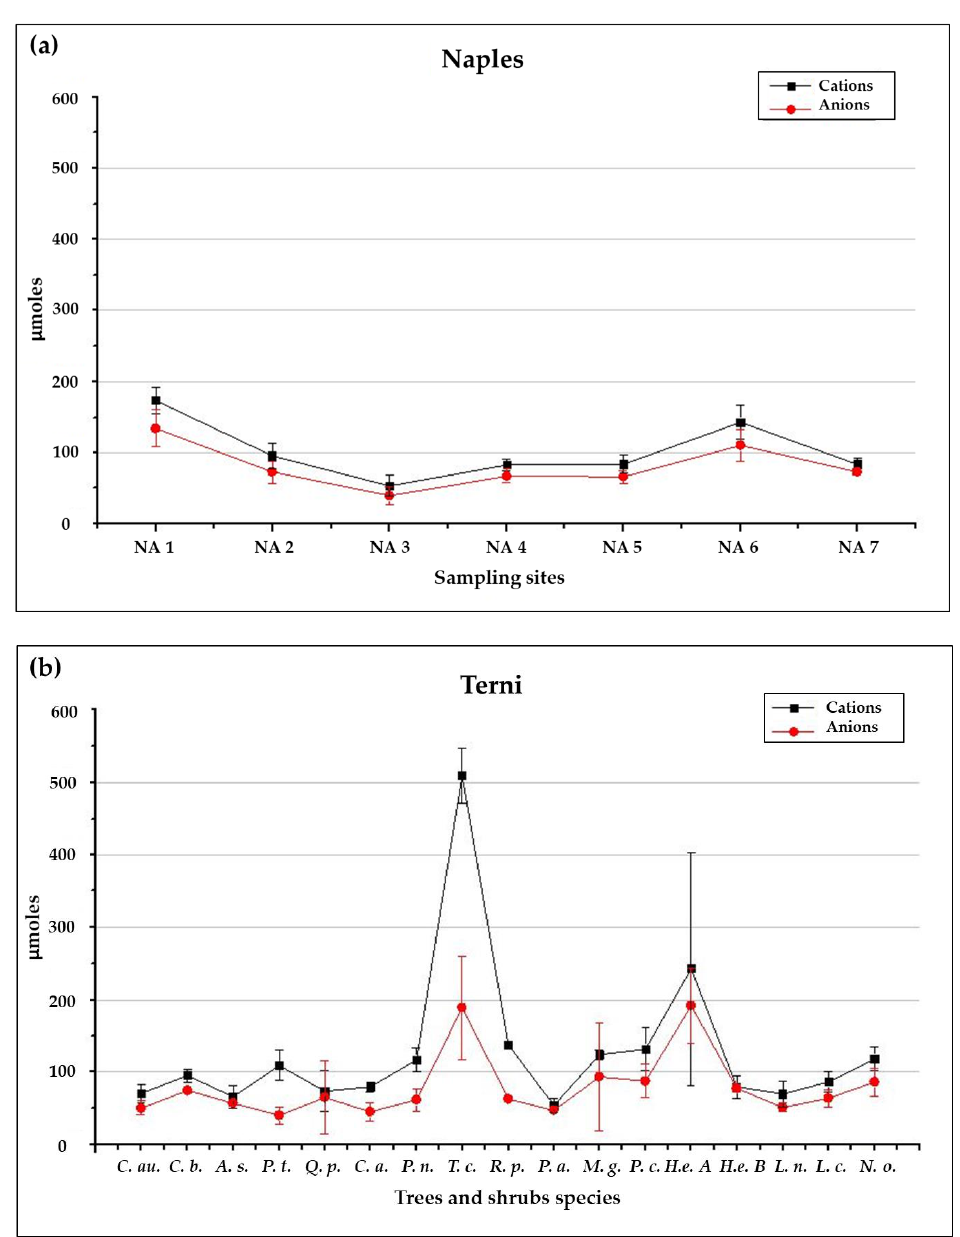
Figure 2. ( a ) Ionic balance of leaf washing solutions averaged over the two replicate branches of each sampling site in Naples; ( b ) Ionic balance of leaf washing solutions averaged over the two replicate branches of each tree and shrub species from Terni. Standard deviation between the two replicates are reported.